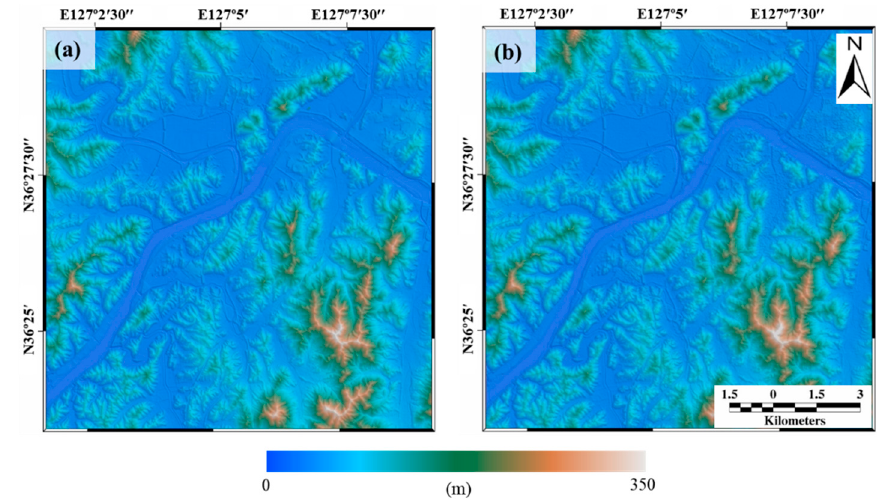
Figure 5. ( a ) Digital Terrain model (10 m) from national geographic information institute (NGII). ( b ) WorldDEM (12 m).